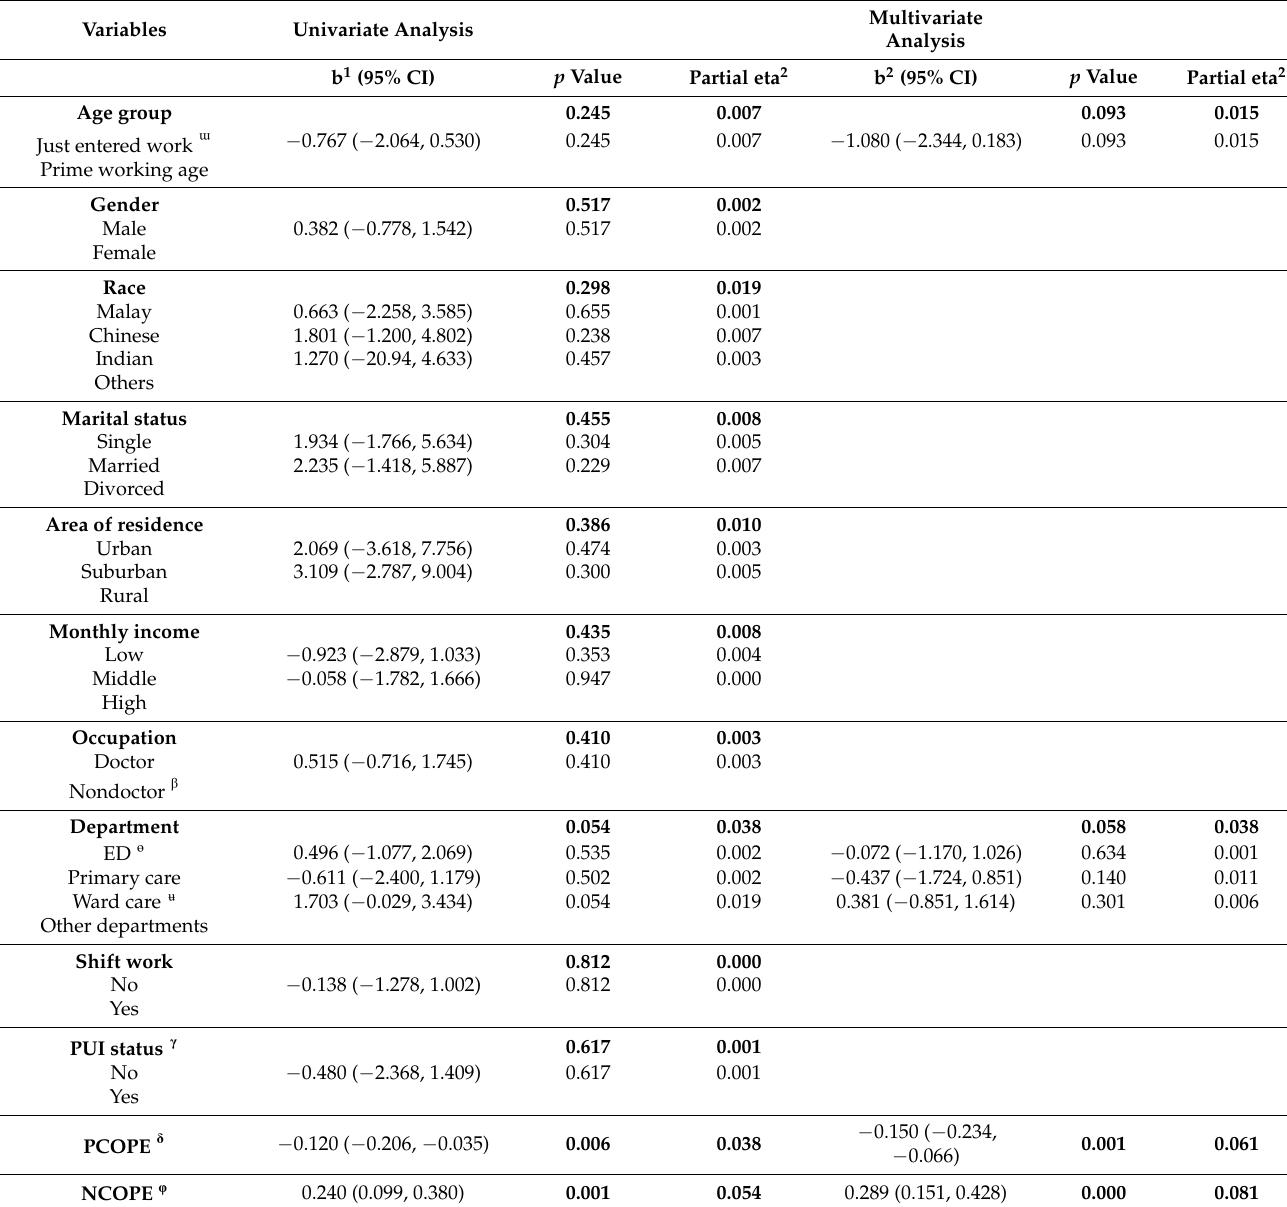
Table 8. General linear model (GLM) on covariates associated with anxiety ( n = 199).